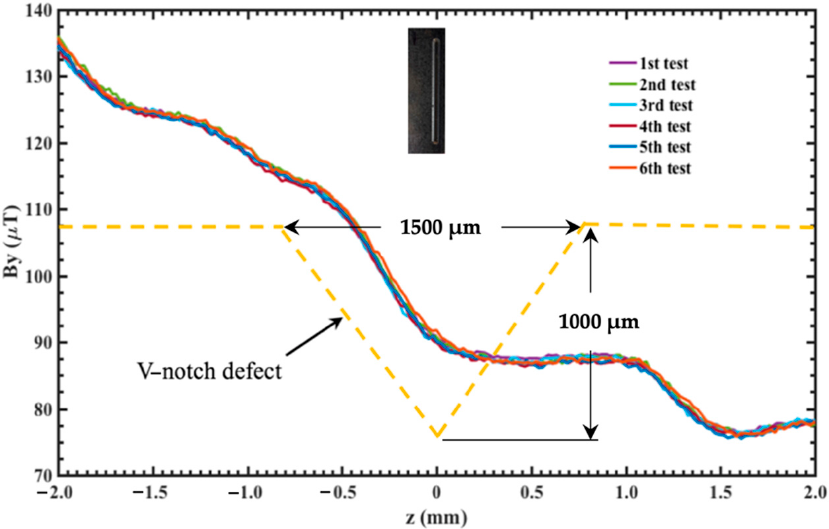
Figure 6. Variation of normal MMM signals measured around the second V-shaped notch (1500 µm width and 1000 µm depth) of the ASTM-A36 steel pipe, which were measured using six experimental tests.